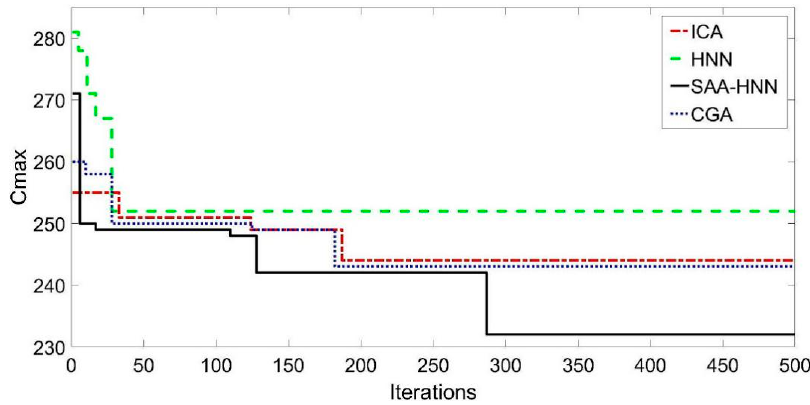
C and the iterations of four algorithms. Figure 5. Correlation between makespan C max and the iterations of four max